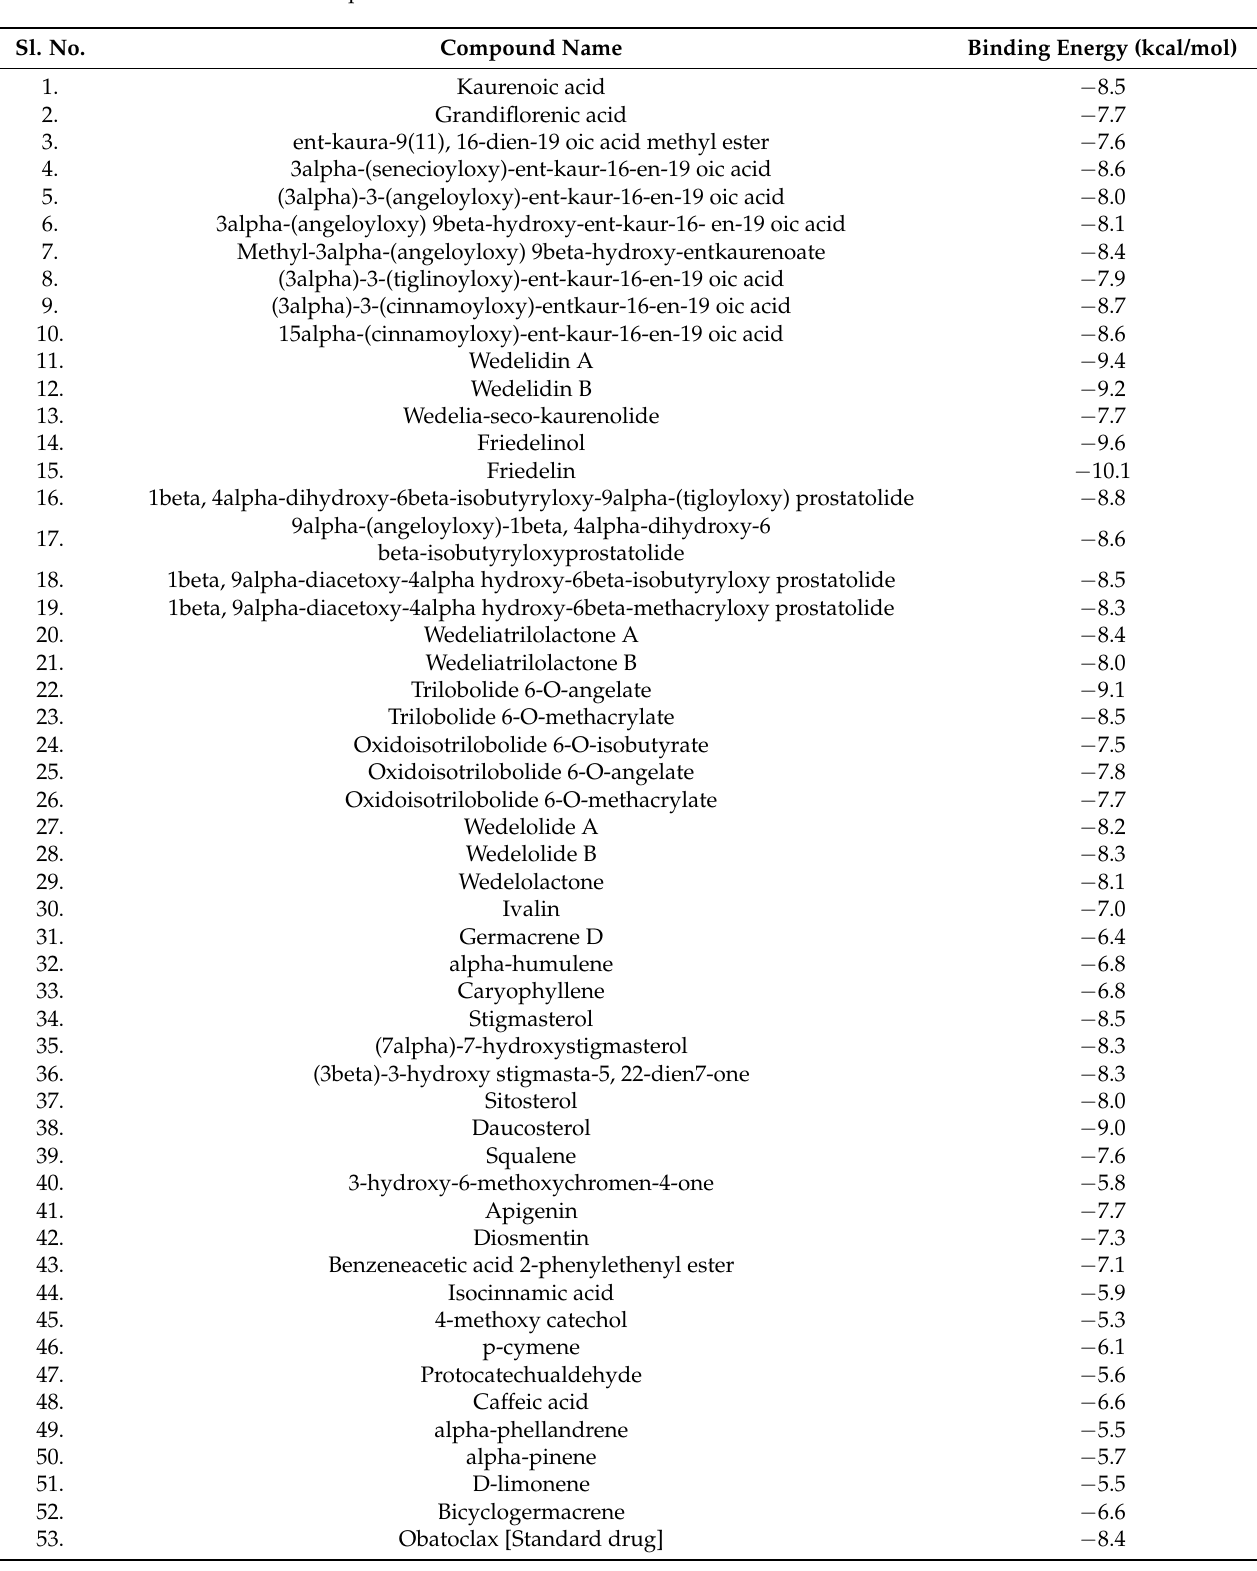
Table 1. Molecular docking results of phytochemicals from W. trilobata and standard drug against Bcl-2